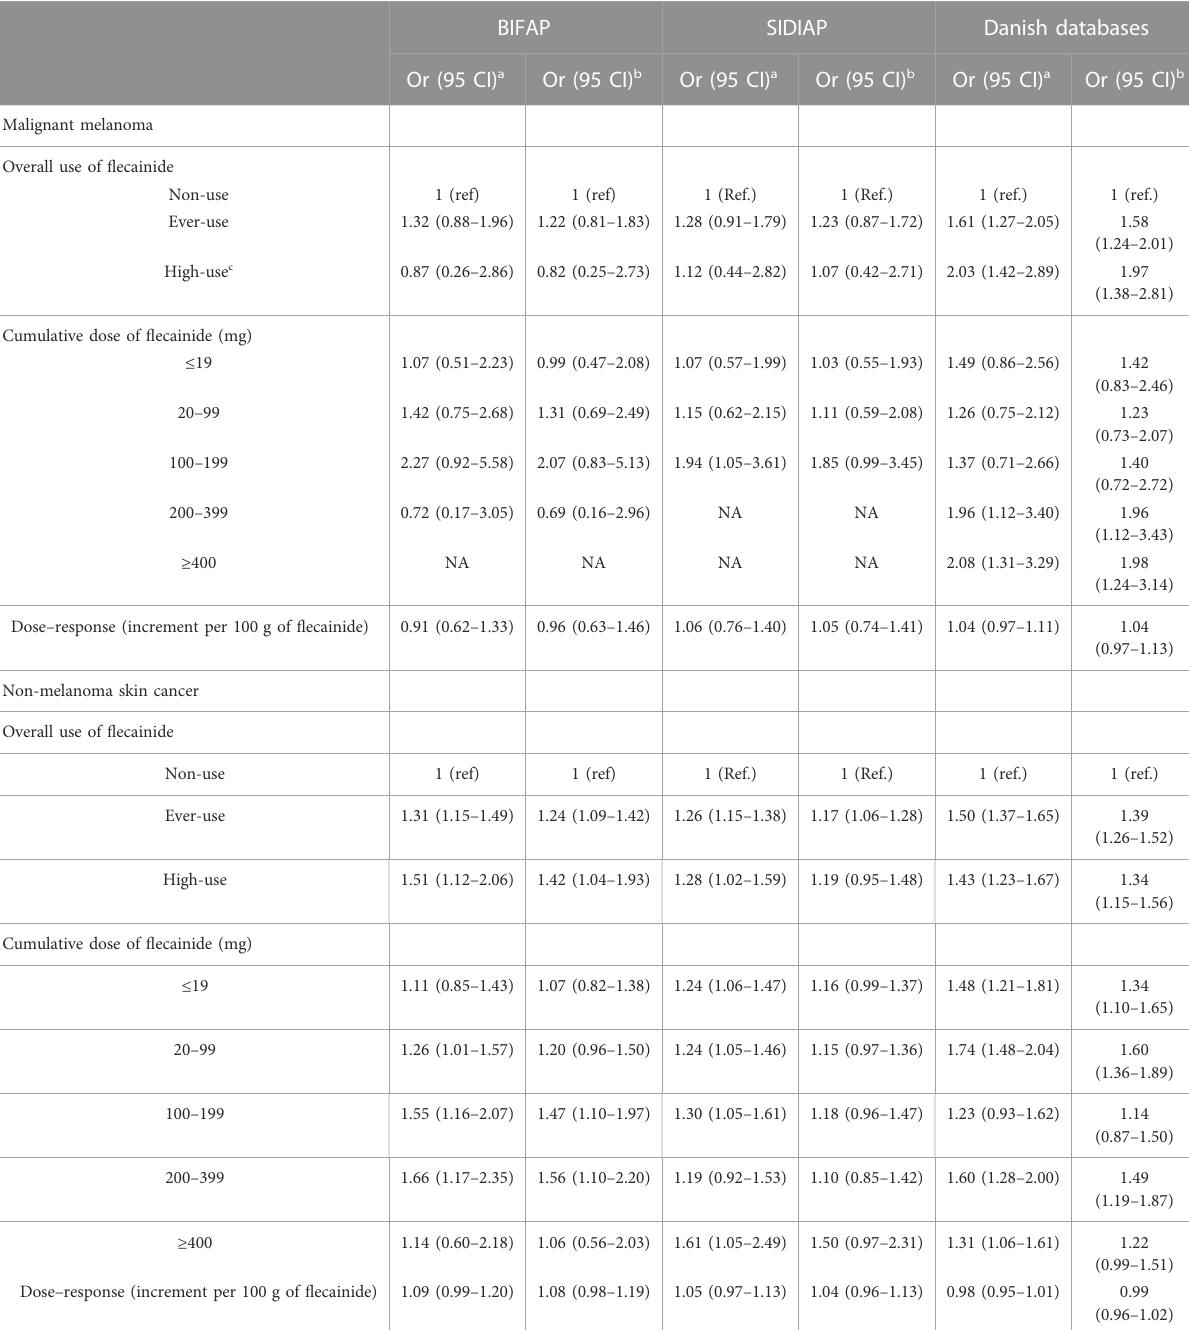
TABLE 2 Association between exposure to fl ecainide and risk of skin cancer, according to cumulative amount of fl ecainide